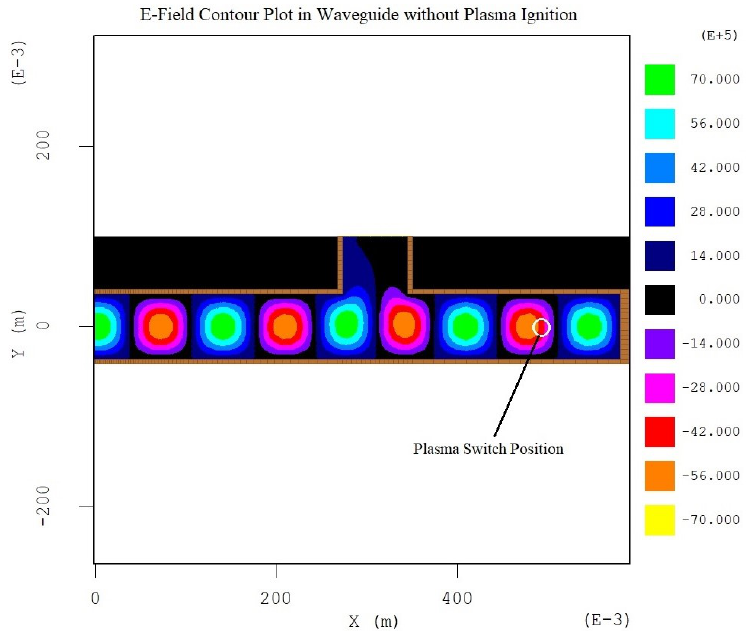
Figure 1. Interaction between standing RF waves and beam switch.